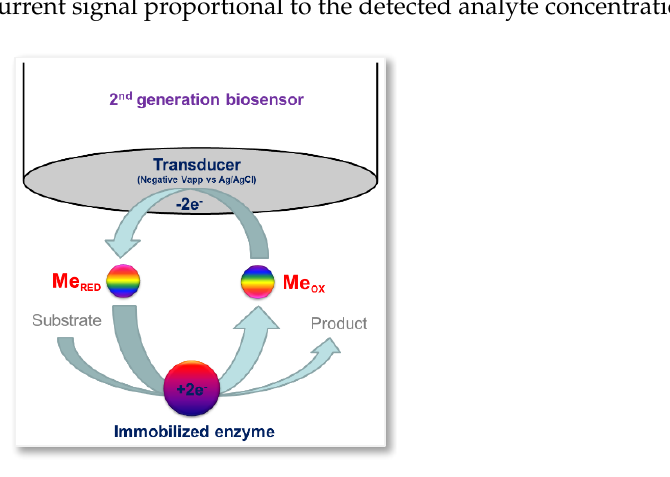
Figure 2. Scheme of a second generation biosensor; Me OX : oxidized mediator; Me RED : reduced mediator.